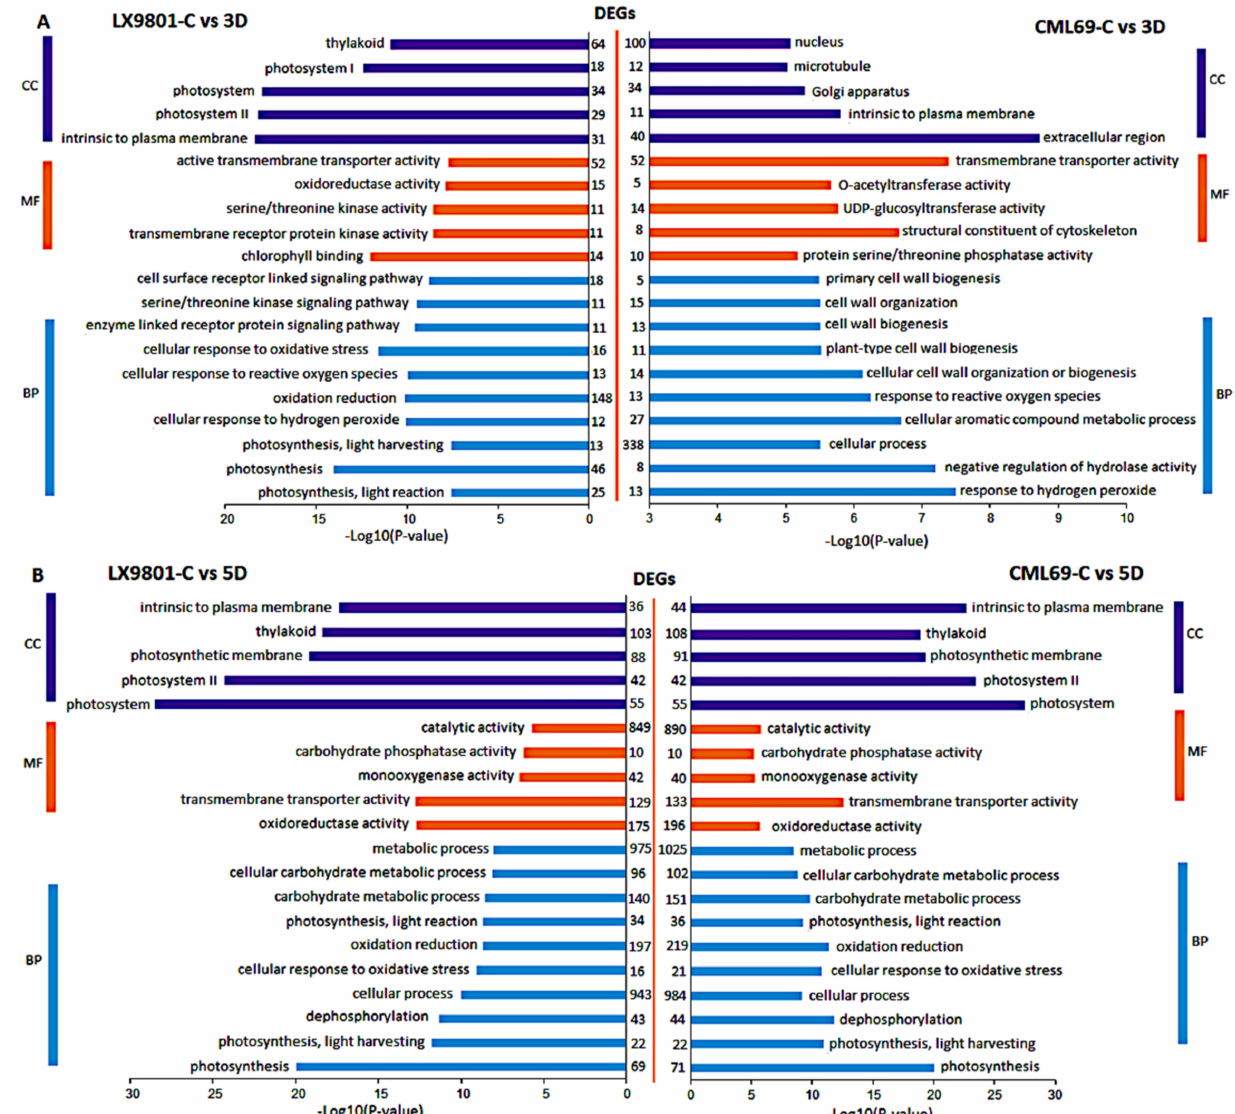
Figure 3. Gene Ontology enrichment analysis of the common drought-responsive genes. ( A ) DEGs expressed at 3D drought stress. ( B ) DEGs expressed at 5D drought stress. The GO terms shown here are the topmost biological process (BP), molecular functions (MF), and cellular component (CC) categories from the tolerant line (CML69) and susceptible line (LX9801). Drought treatments are labeled as control (C), three days (3D), and five days